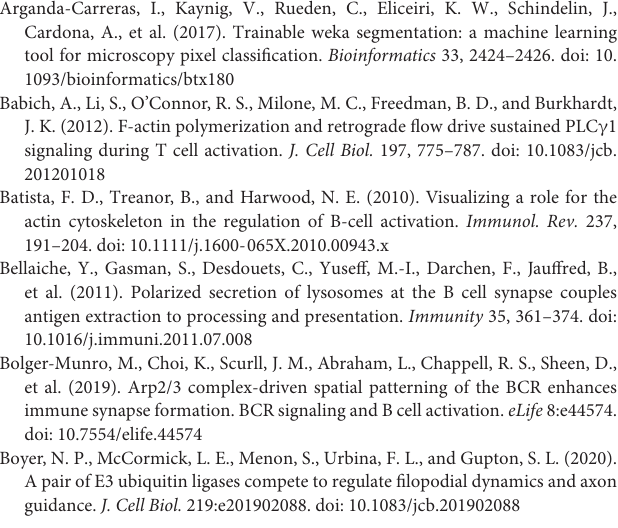
Supplementary Figure 5 | Proteasome arrival at the IS negatively regulates actin polymerization. (A,C,E,G) Representative TIRFM images of control, MG-132 pre-treated (5 µ M for 1 h), Bsc2118-FL-Bodipy overdosed (100 nM), and Ecm29-silenced (siECM29) B cells. B cells were plated for 30 min onto antigen-coated coverslips and then recorded. LifeAct-mCherry (white) and proteasome (green [Bsc2118-FL-Bodipy]), magnifications proteasome spots (white dashed rectangles), together with their respective kymograph, are shown. White arrowheads indicate the proteasome arrival at the IS close to F-actin structures. (B,D,F,H) Quantification of the proteasome (green) and LifeAct-mCherry (Red) distribution at proteasome positive spots (white dashed line) and their distribution in time (Kymograph) showed on (A,C,D,G) , respectively. (I) Scheme illustrating the quantification rationale and results of the quantification of normalized fluorescence intensity correlation between Bsc2118-FL-Bodipy and LifeAct-mCherry, on Bsc2118-FL-Bodipy-positive spots of 1 µ m in diameter shown in (A,C,G,E) . N > 10. ∗ p < 0.05. ∗∗ p < 0.001. ∗∗∗ p < 0.0005. ∗∗∗∗ p < 0.0001. Kruskal–Wallis test with Dunn’s test was performed for all statistical analyses was performed. Each dot represents an independent positive Bsc2118-FL-Bodipy spot. Mean with SEM lines are shown. Scale Bar = 10 µ m. Supplementary Figure 6 | Centrosome-nucleus separation and centrosome recruitment to the IS is impaired in Ecm29-silenced B cells: (A) Representative Epifluorescence images of control (siCTL) and Ecm29-silenced (siECM29) B cells, activated with antigen-coated beads for different time points. Centrosome (Centrin-GFP) and nucleus (DAPI) are shown. The dashed line represents the distance between the centrosome-nucleus. A scheme depicting how the cell polarity index and the distance between the centrosome and nucleus were calculated, is shown. (B,C ) Quantification of centrosome-nucleus distances and centrosome polarization in (A). N > 3. Cells > 116. Each dot represents an individual measurement (C). Mean with SEM lines (C) and bars (B) are shown. ∗∗∗ p < 0.0005. ∗∗∗∗ p < 0.0001. Kruskal–Wallis test with Dunn’s test was performed. Scale Bar = 10 µ